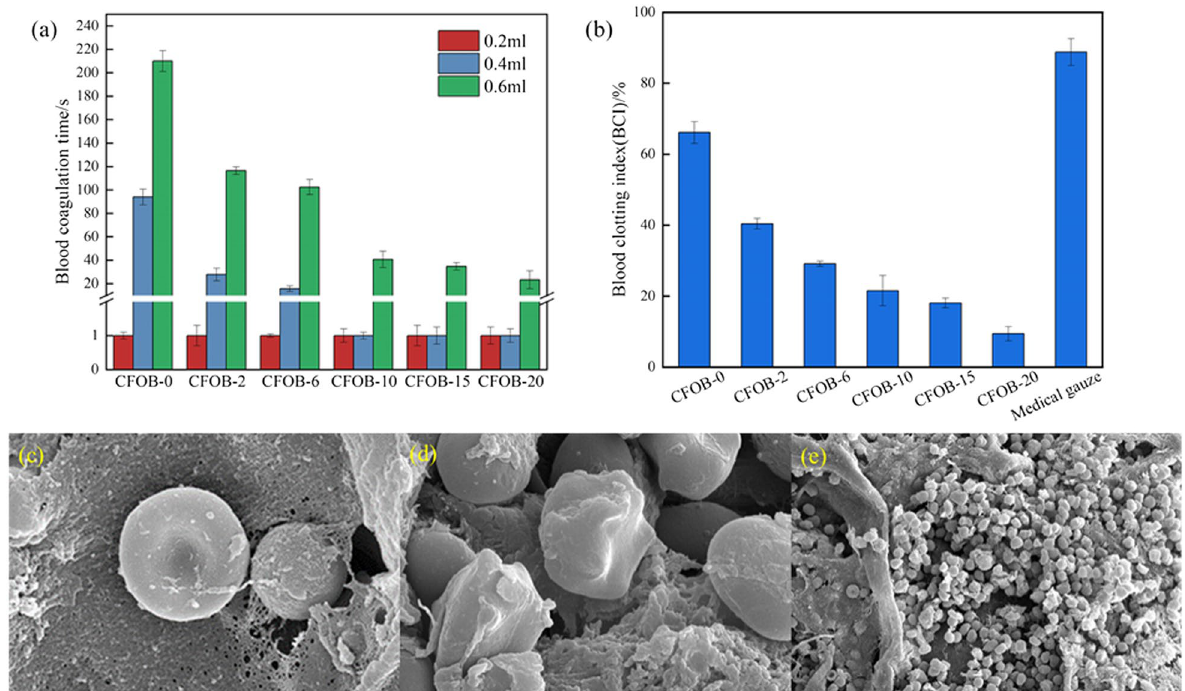
Fig. 7 a Blood coagulation time of CFOB with different OBSP dosages, b BCI of CFOB with different OBSP dosages, the observation of blood cells andmaterial interaction via electron microscope: c at 1 min, red blood cells adhere to the surface of CFOB, 10,000 cells expand and expand pseudopodia accompanied by aggregation and adhesion to CFOB sponge, 10,000 aggregate in large numbers, 1000